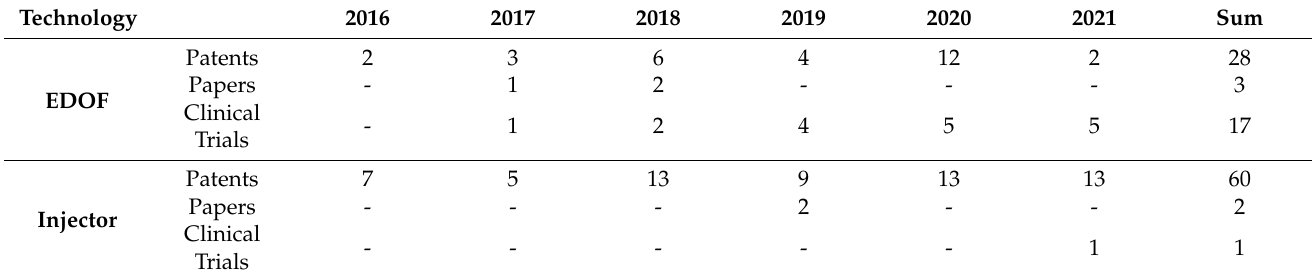
Table 2. Number of patents, papers, and clinical trials on recent